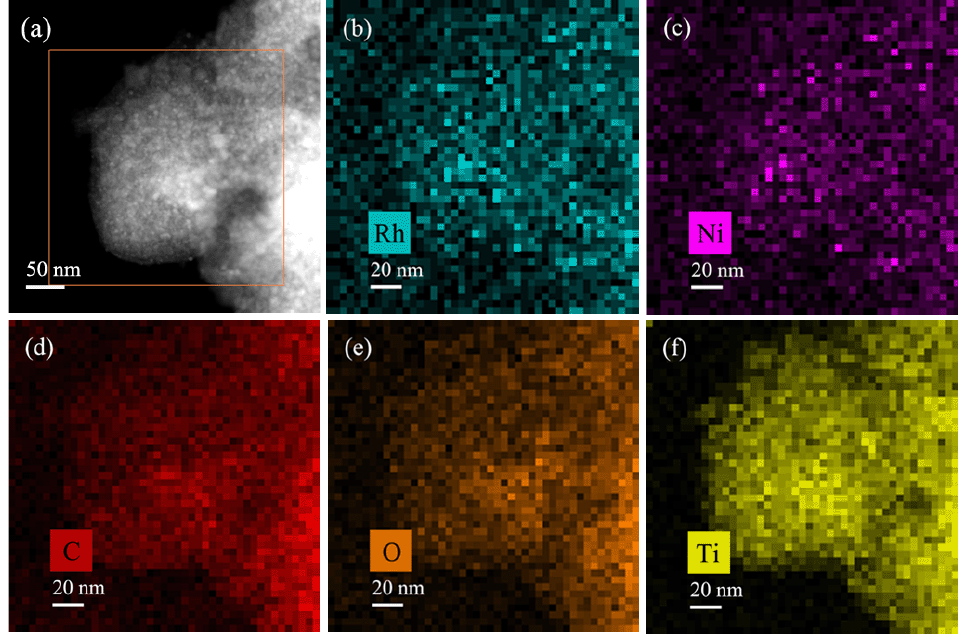
Figure 4. The STEM-HAADF images of the Rh 0.8 Ni 0.2 /MXene ( a ) and the corresponding elemental mapping images for Rh ( b ), Ni ( c ), C ( d ), O ( e ) and Ti ( f ). Reprinted with Permission from [63].